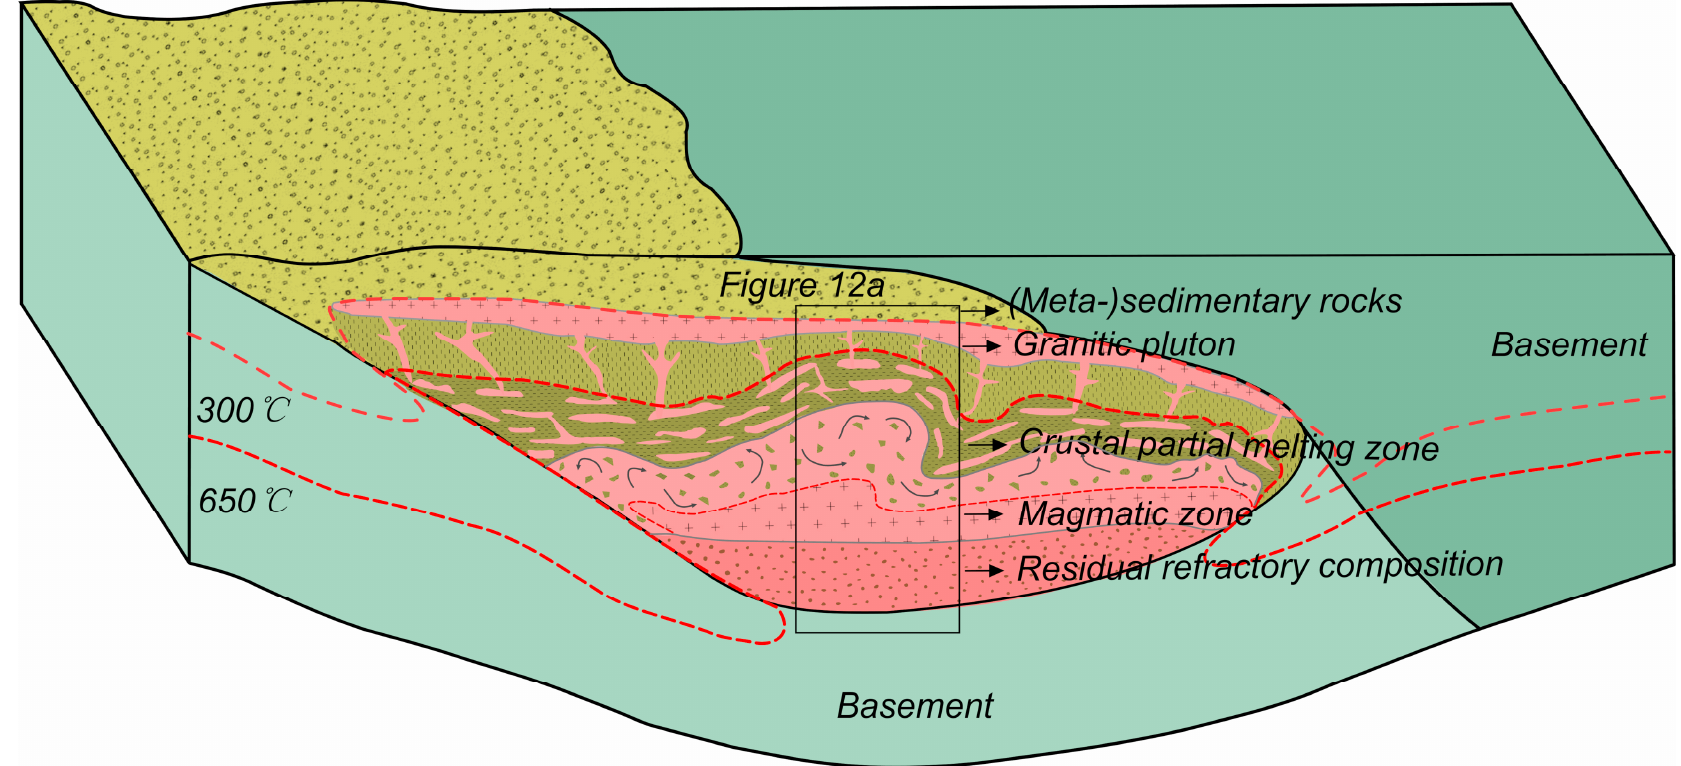
Figure 13. Conceptual model for crustal partial melting in the Yunkai region during the Early Paleozoic Wuyi–Yunkai orogen. The pink and the red thick dashed lines represent the isotherms of 300°C and 650°C, respectively.